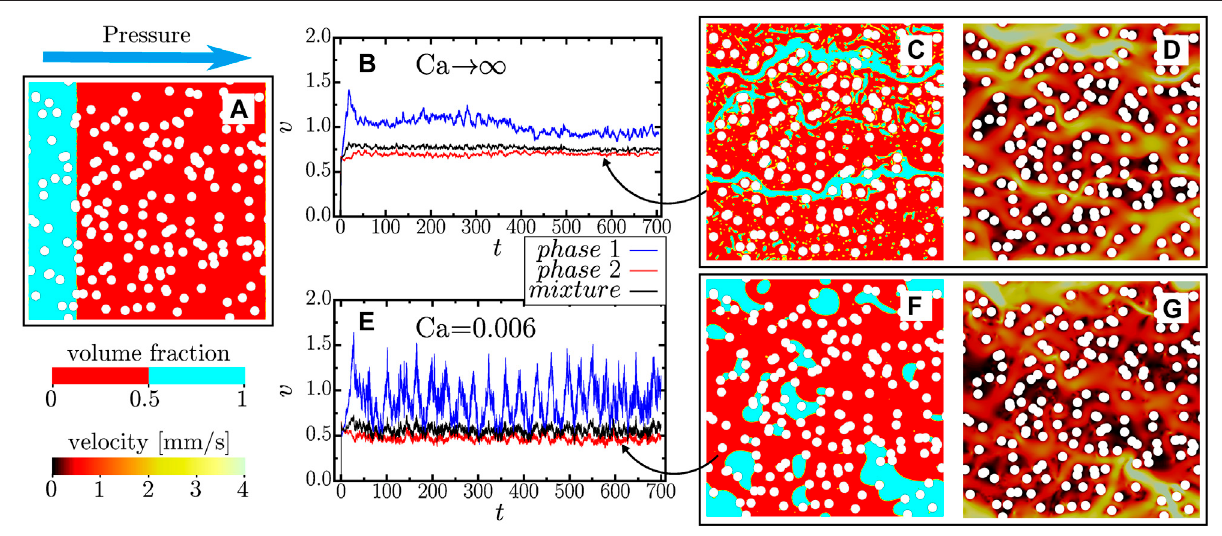
FIGURE 1 | Time evolution of the two-phase fl ow starting from an initial condition (A) where the fi lling fraction of the lower viscous phase is set to S 1 = 0.2. (B – D) describe the case for Ca → ∞ while the case for Ca = 0.006 is shown in (E – G) . In both cases, the pressure drop is ∇ P = 1.0 kPa/m and the viscosity ratio is M = 10. The time series of the averaged x -component velocity for phase 1 (blue curves), phase 2 (red curves), and the mixture (black curves), computed with Eqs 3 – 5 , are shown in (B,E) . (C,F) show typical con fi gurations of the two-phase fl ow in the stationary regime. For high capillary numbers, (B) phase 1 is scattered into several small droplets and few fi ngers (long and thin clusters), while for small capillary numbers, (F) phase 1 forms large drops. The corresponding velocity fi elds of the mixture are shown in (D,G) , with velocities ranging from 0.0 to 4.0 mm/s. Brighter colors represent regions of high speeds. Large bubbles, of the order of the system size, can be trapped and cause large fl uctuations as shown in (E)